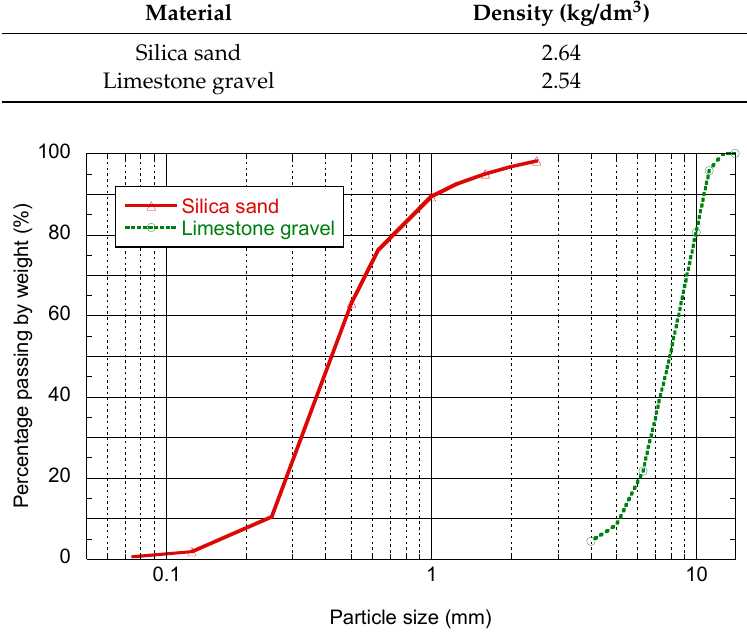
Table 2. Aggregate densities.